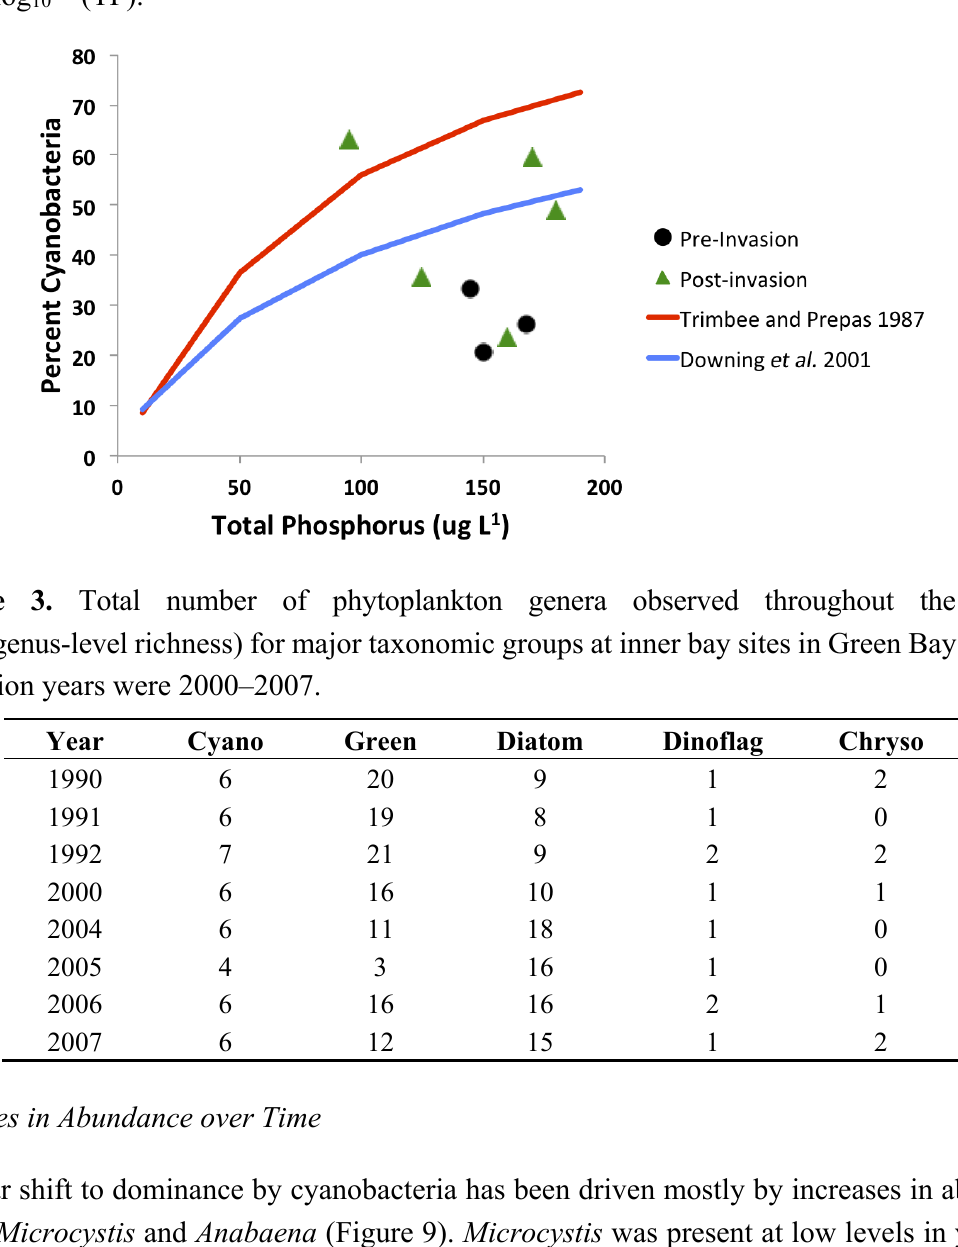
Figure 8. Relative contribution of cyanobacteria to total phytoplankton biovolume as a function of total phosphorus in the inner bay of Green Bay. Black dots indicate mean summer values for pre-invasion years while green triangles show post-invasion years. Lines are predicted relationships based on comparison of a cyanobacteria (blue green algae) index to TP where BG Index = ln (%B/(100%BG) (from [35]). The plotted lines are from published equations from [35]: BG Index = − 5.00 + 2.62 log 10 * (TP) and [36]: BG Index = − 4.16 + 1.88 log 10 * (TP).